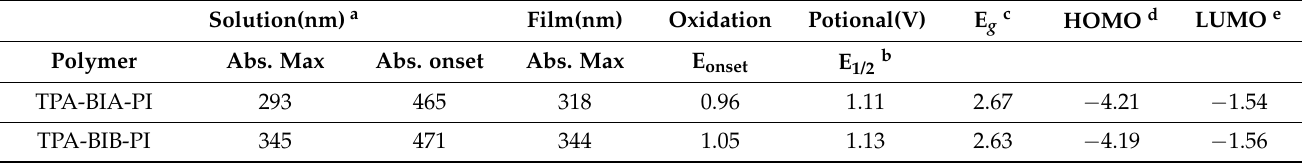
Figure 6. UV–vis absorption spectra of TPA-BIA-PI and TPA-BIB-PI in NMP solutions ( a ) and solid films ( b ). Table 3. Experimental and Calculated Oxidation Potentials and Energy Levels of PIs.